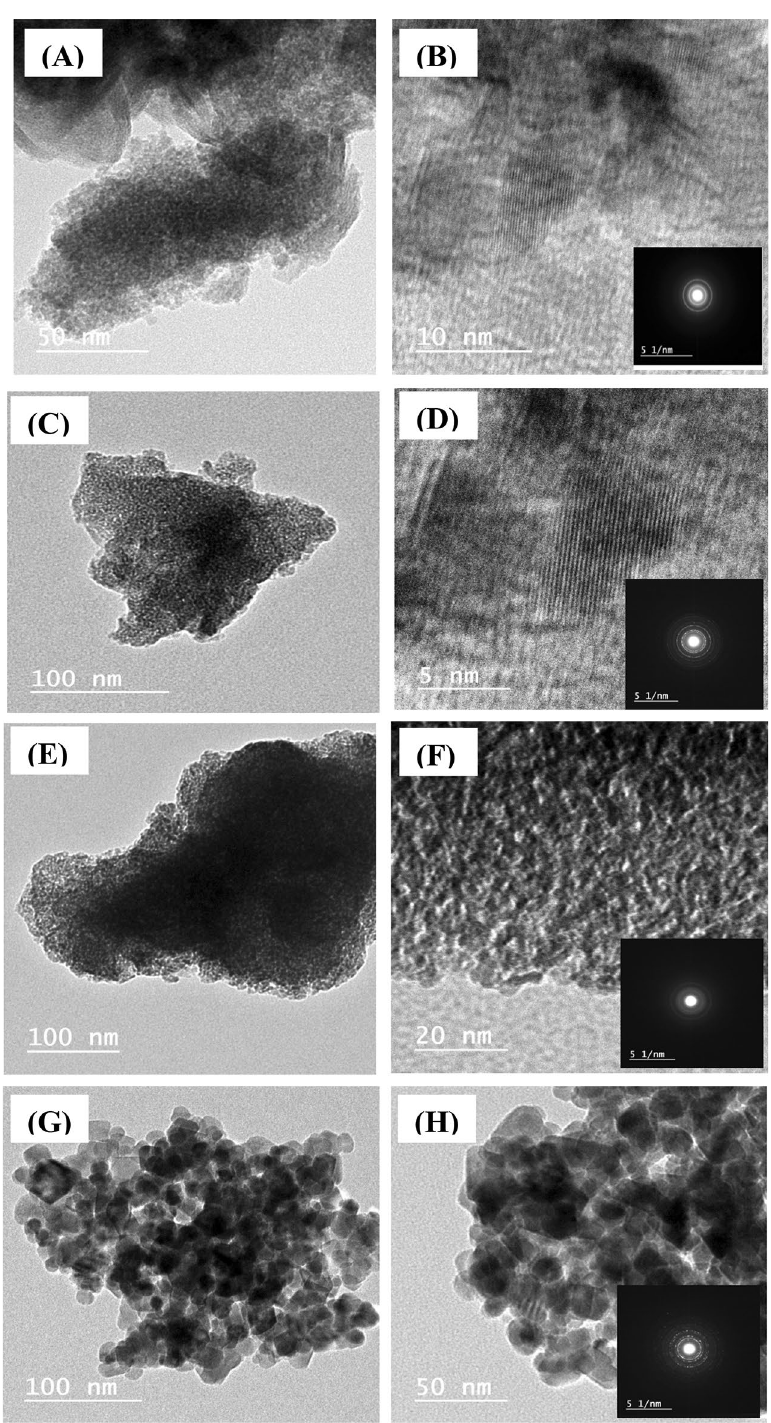
Figure 4. HRTEM images of as-prepared LDH sample ( A , B ); HRTEM images of LDH sample after adsorption at different calcination temperatures, 200 °C ( C , D ), 400 °C ( E , F ), and 600 °C ( G , H ). Insets are the corresponding SAED